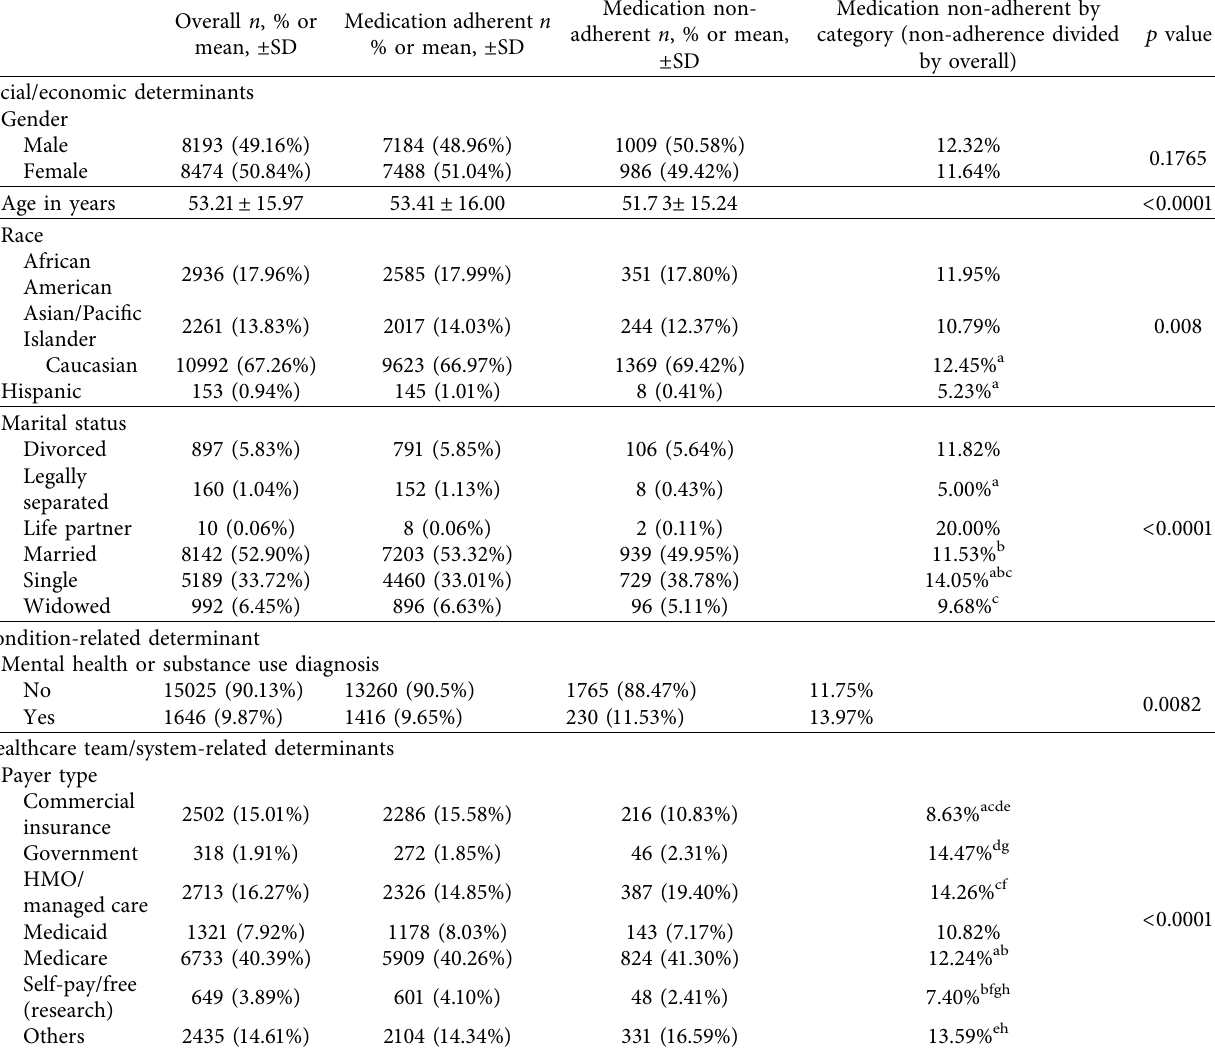
Table 1: Condition, therapy, and health care team/system factors by post-transplant medication adherence and nonadherence. Overall n , % or mean, ± SD